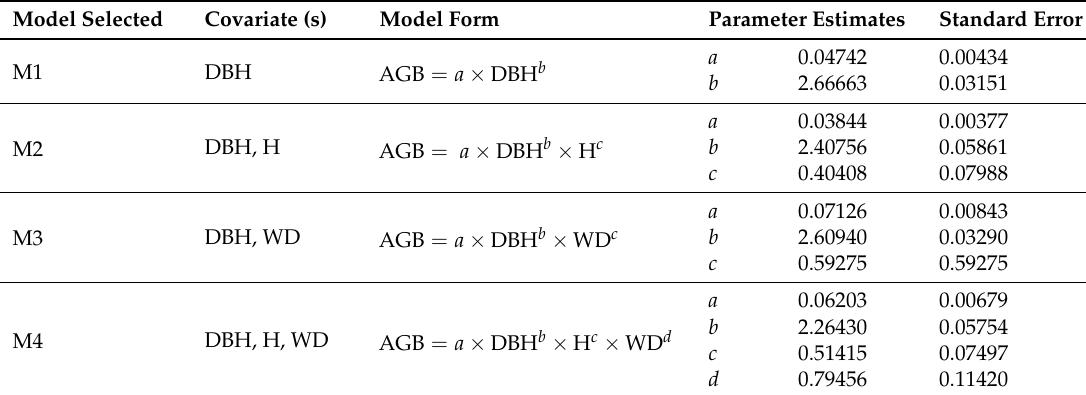
Table 4. Selected AGB models with different input variables, their parameter estimates, and standard errors for mixed-species of the dipterocarp forests (based on the entire dataset, 222 trees). Model